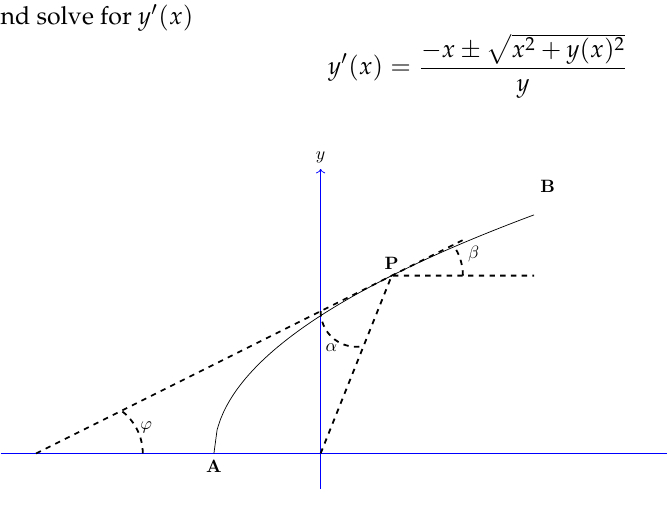
Figure 10. Parabolic mirror 109 Figure 11. Parabolic mirror.